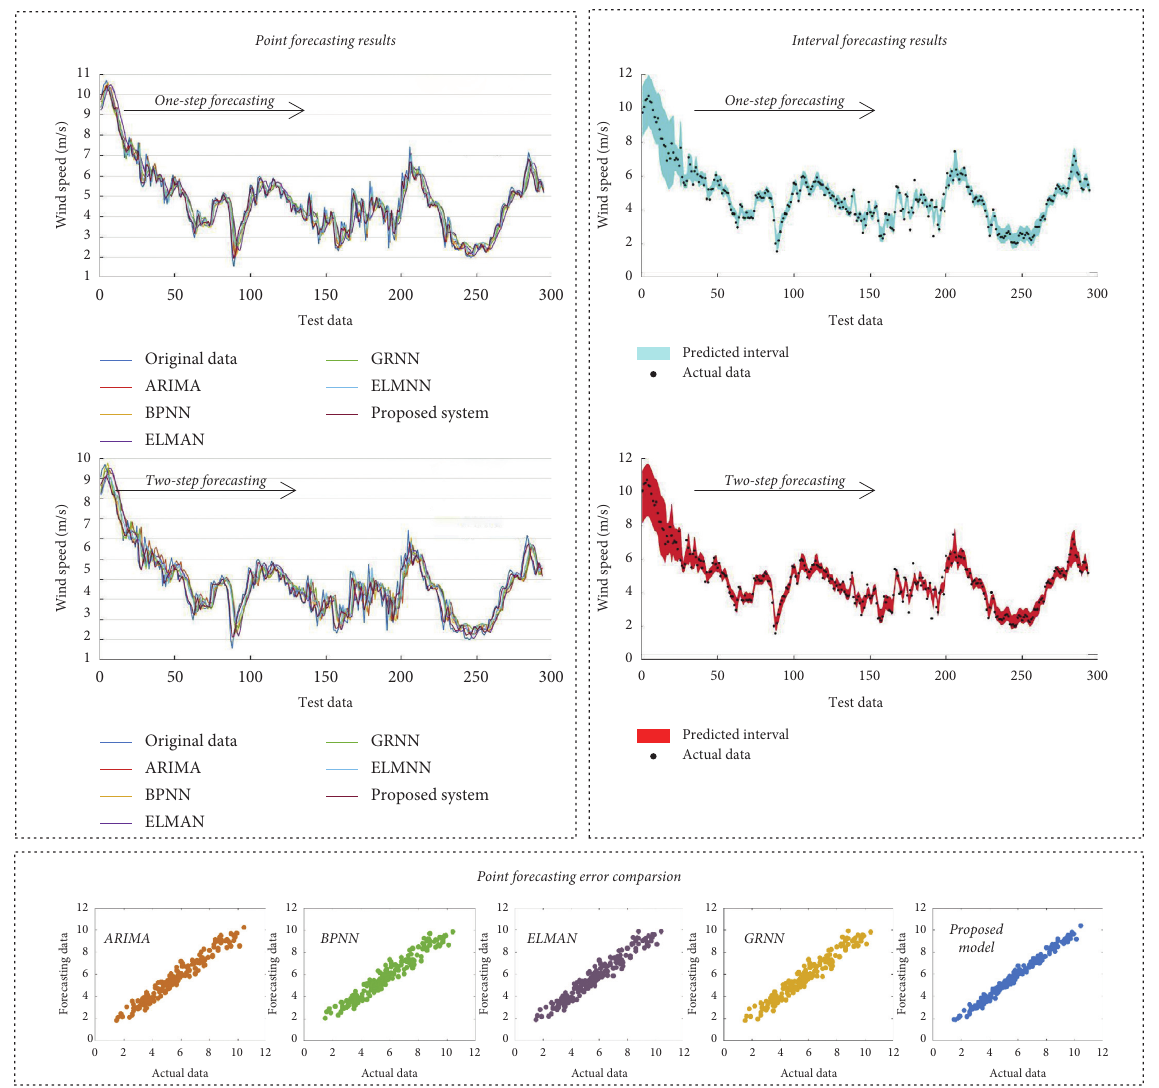
Figure 4: Experiment III: comparison with classic individual